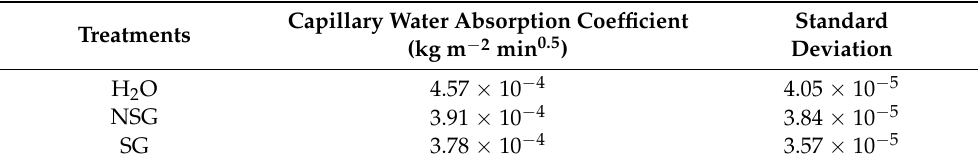
Table 3. The measurement result of capillary water absorption coefficient of concrete specimens with recycled aggregate treated with NSG, SG, and